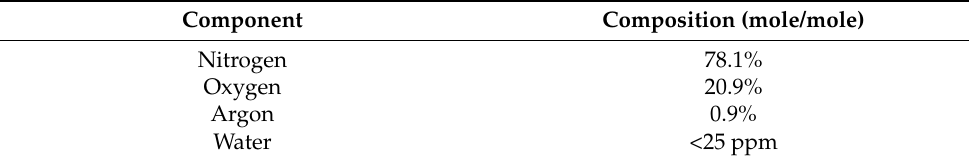
Table 2. Breakdown of sensor system component costs.